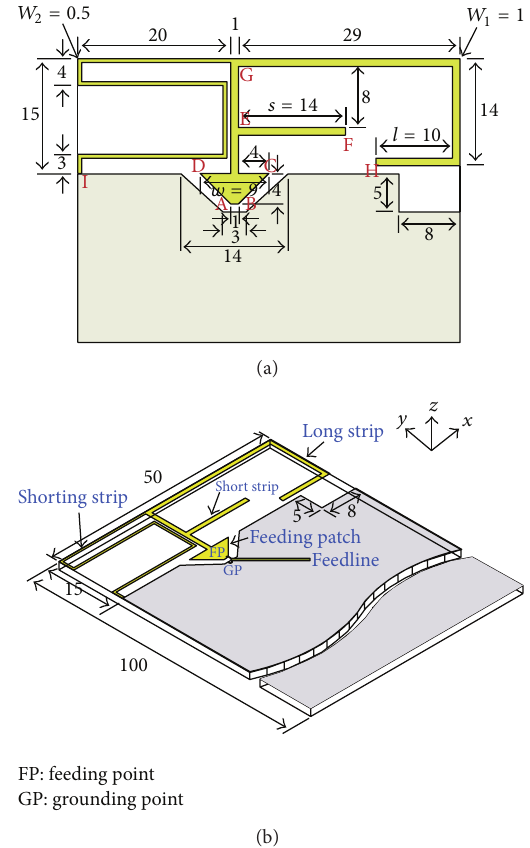
Figure 1: Geometry of the proposed multiband monopole antenna with the inverted-trapezoidal coplanar waveguide (CPW) feeding (unit: